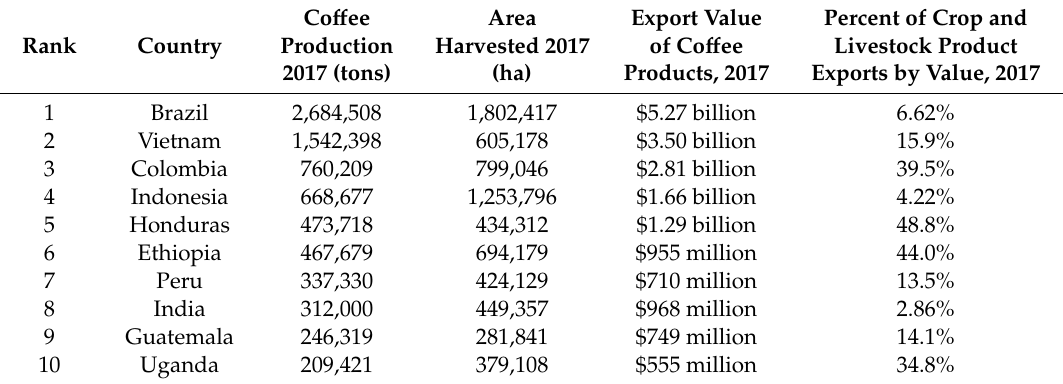
Table 1. Statistics on the top ten co ff ee-producing countries ranked by co ff ee production. Data collected from the Food and Agriculture Organization of the United Nations